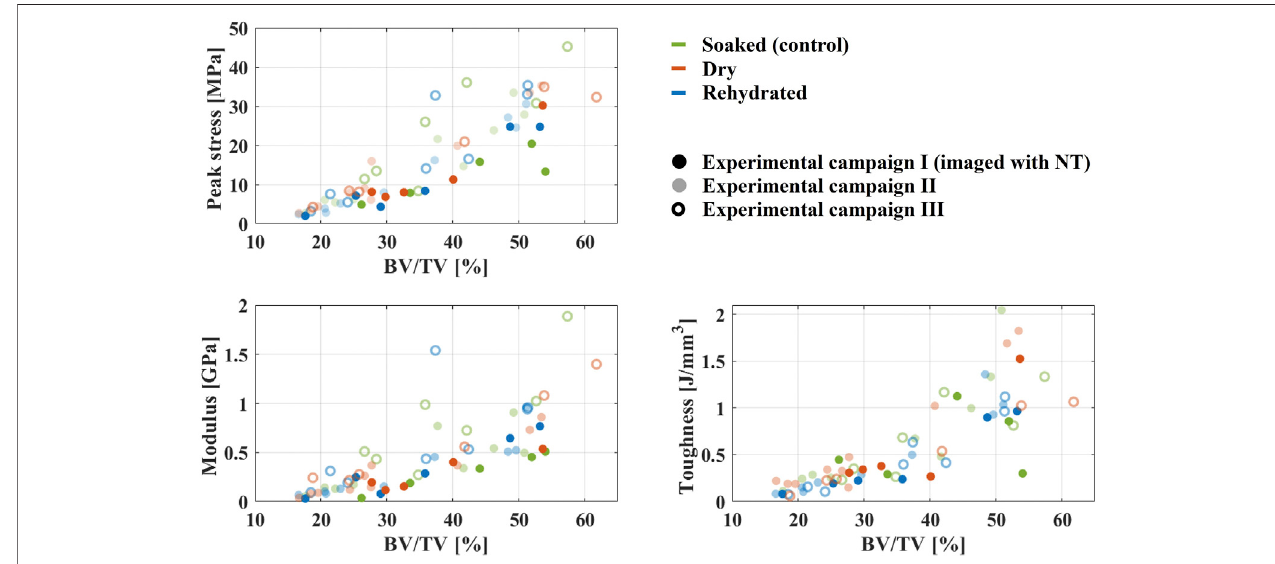
FIGURE 5 | Mechanical properties as a function of bone volume fraction (BV/TV). Hydration groups are color coded as soaked — green, dried — red, rehydrated — blue. The specimens imaged with neutron tomography (tested during experimental campaign I) are shown in opaque colors. The specimens tested during experimental campaign II are shown in transparent colors. The specimens tested during experimental campaign III are shown as outlined circles.